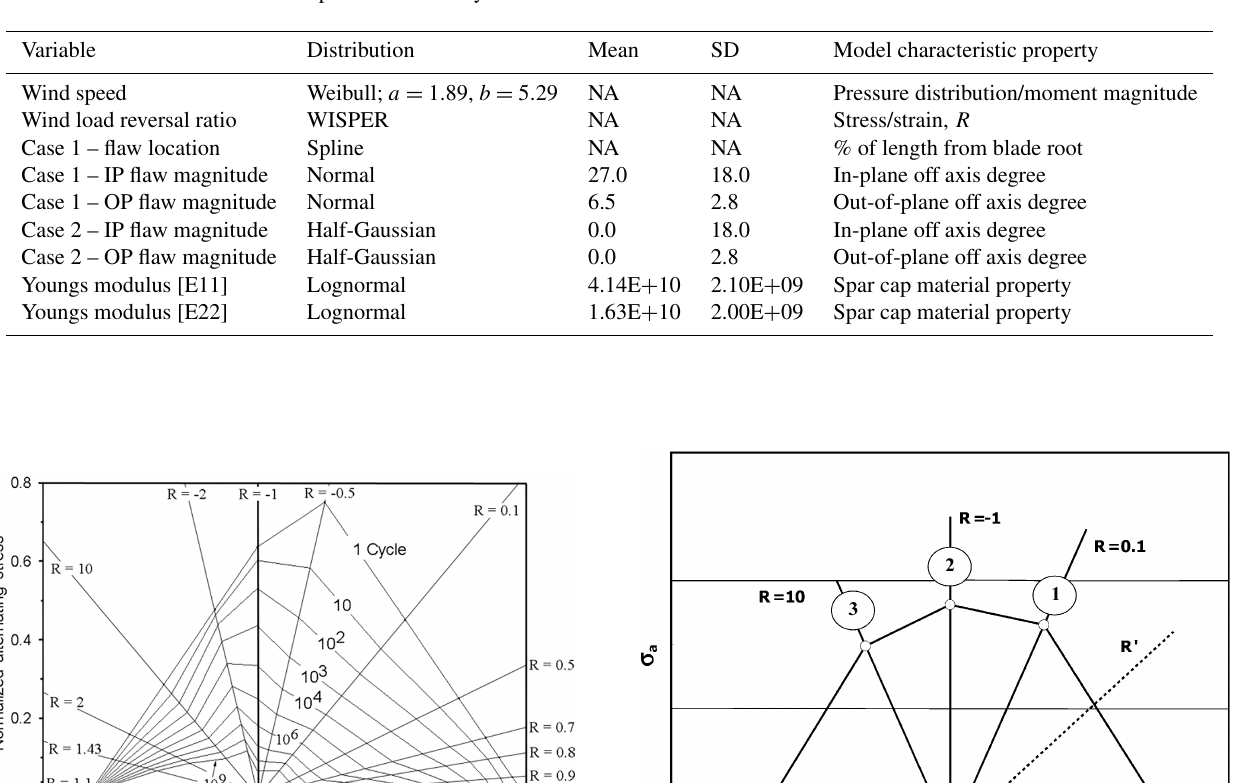
Figure 5. Representative shifted S − N curve associated with knockdown factor. Table 2. Stochastic variables used in probabilistic analysis.